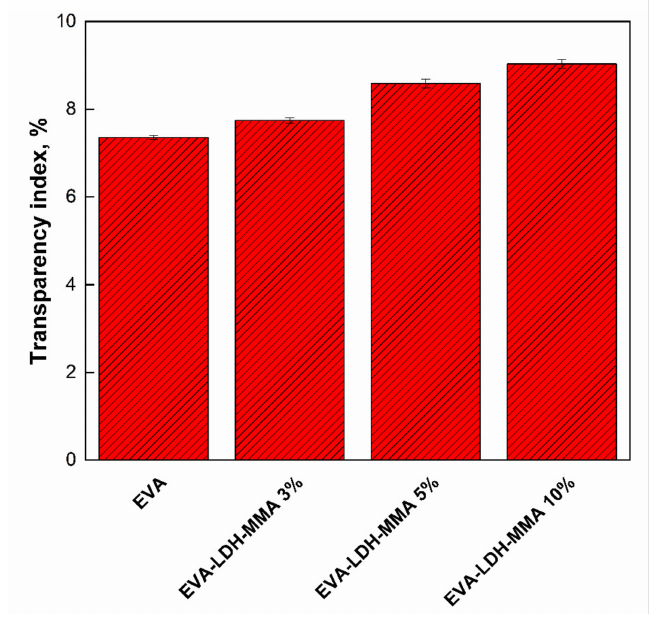
Figure 6. Transparency index (%) of neat EVA and EVA + LDH/MA films.